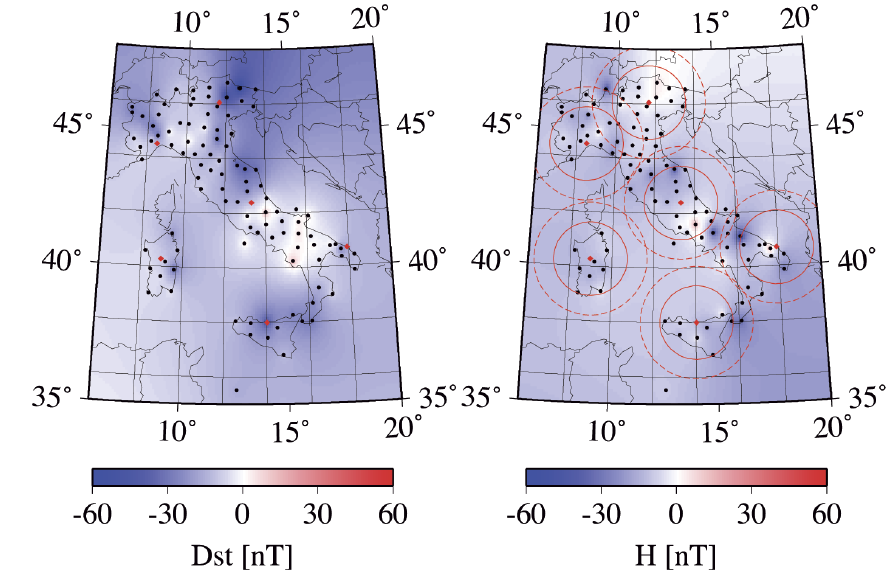
Figure 4. On the left a map of the difference of daily Dst index at the times of 2000.0 and 2010.0 surveys, on the right the map of D R for the horizontal component H . Black dots indicate the position of magnetic repeat stations, red dots indicate the position of magnetic observatories and variometers. Dashed circles have a radius of 230 km, while solid circles have a radius of 150